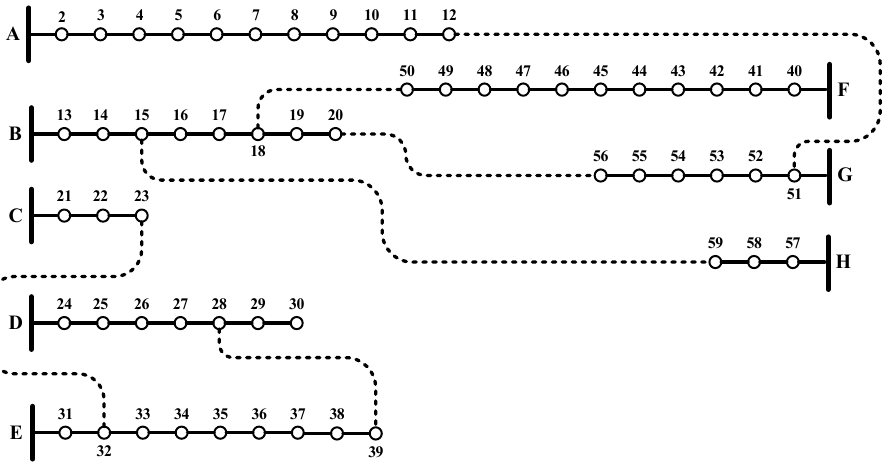
Figure 3. Real 59-node distribution system in Cairo.